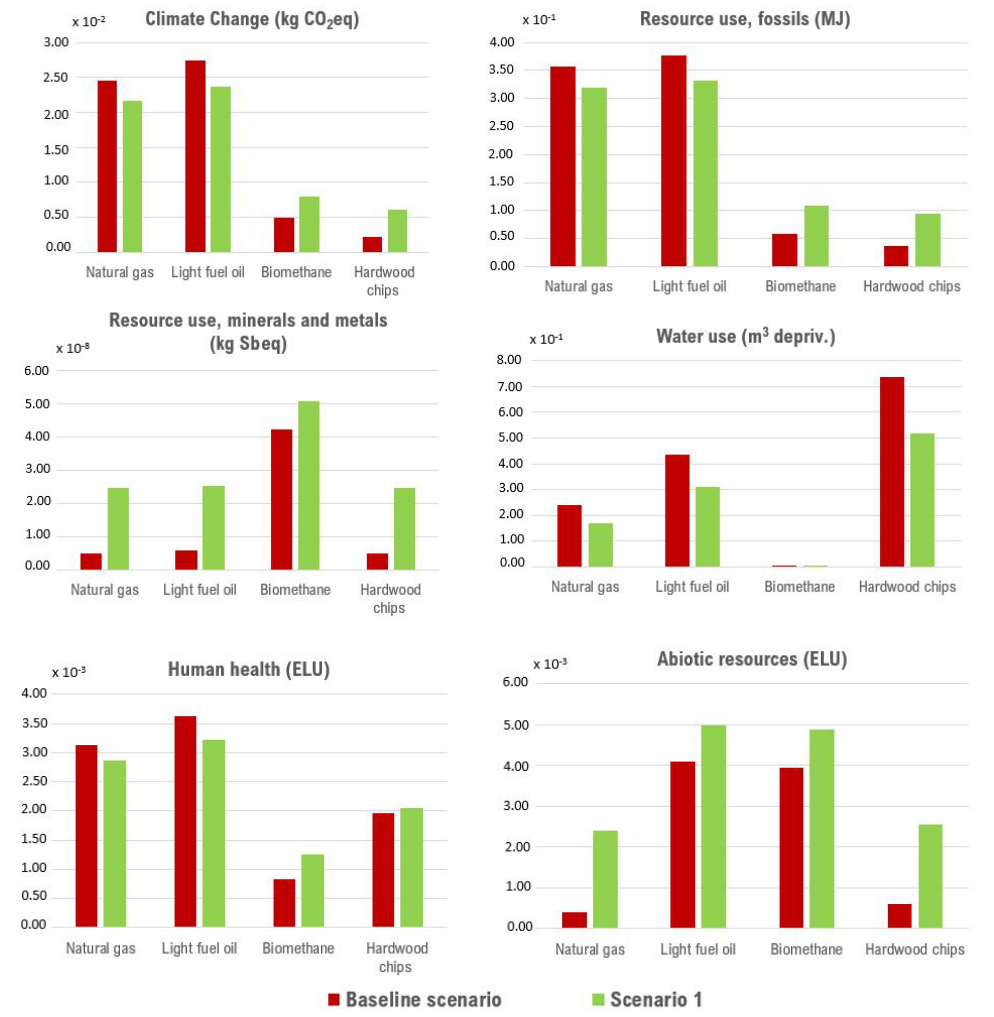
Figure 5. LCA and eLCC results for Baseline Scenario and Scenario 1 (FU: 1 kg dried